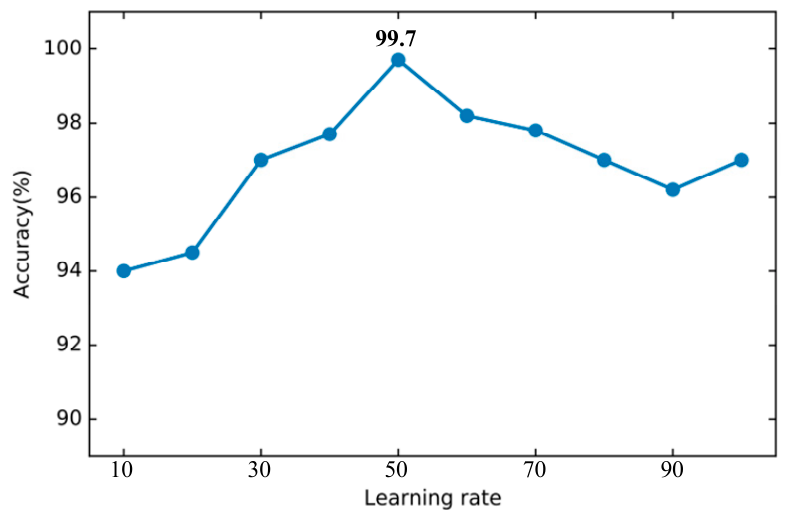
Figure 12. Accuracy of decision tree using different number of features.